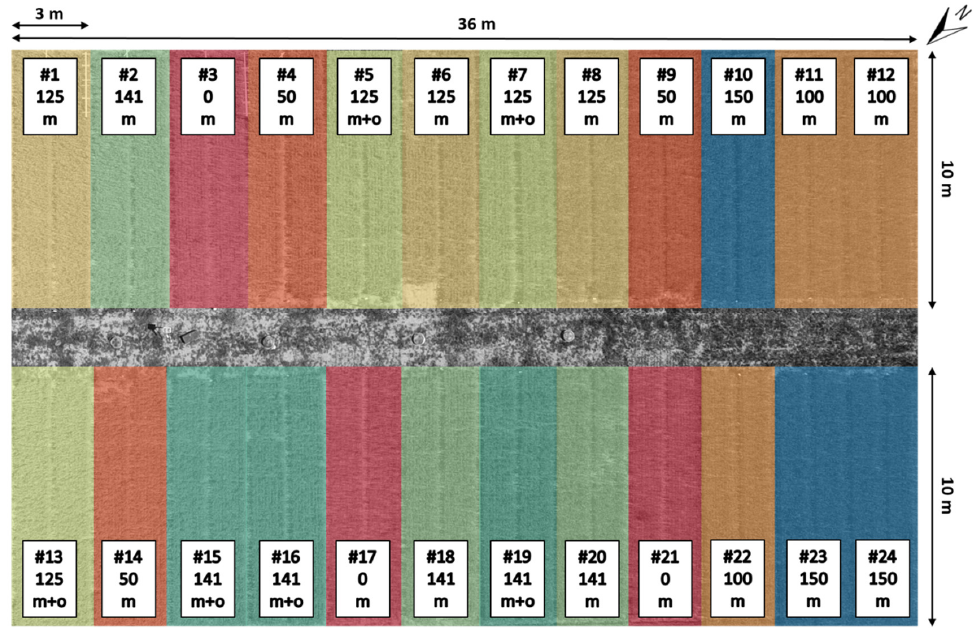
Figure 1. Overview of the study site; each plot colorized by treatment, numbered, and labeled with applied N amounts and N types. m: mineral, o: organic.